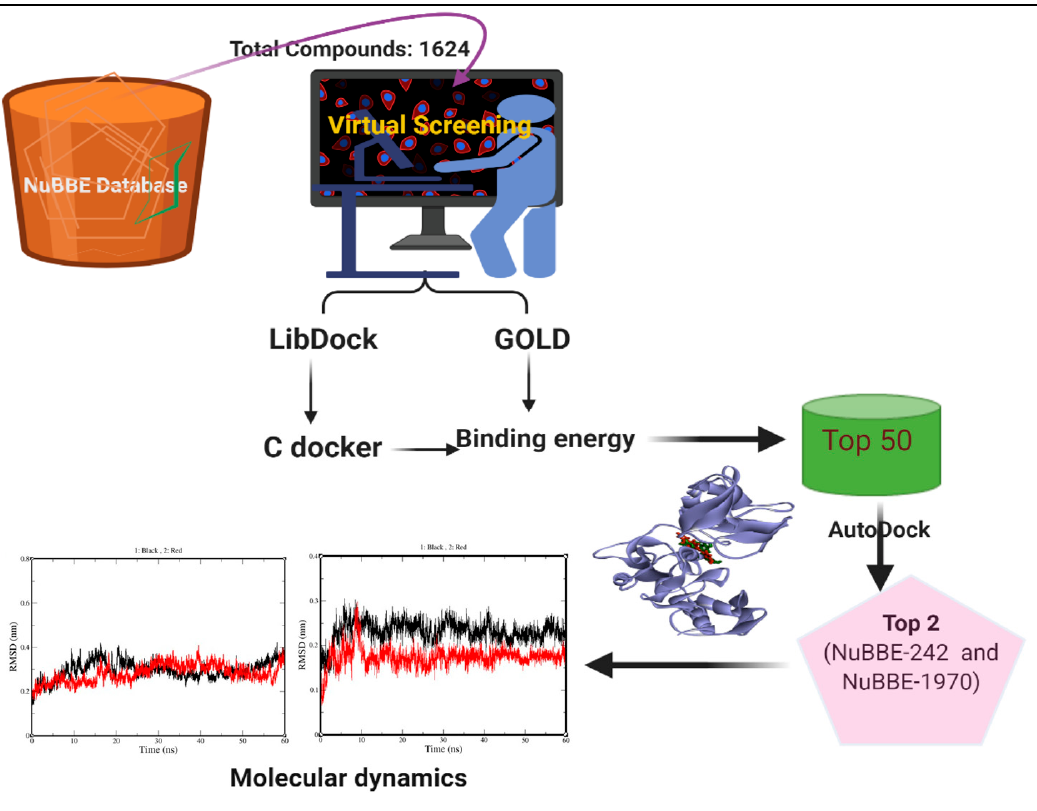
Figure 1. Flow diagram of virtual-screening steps.